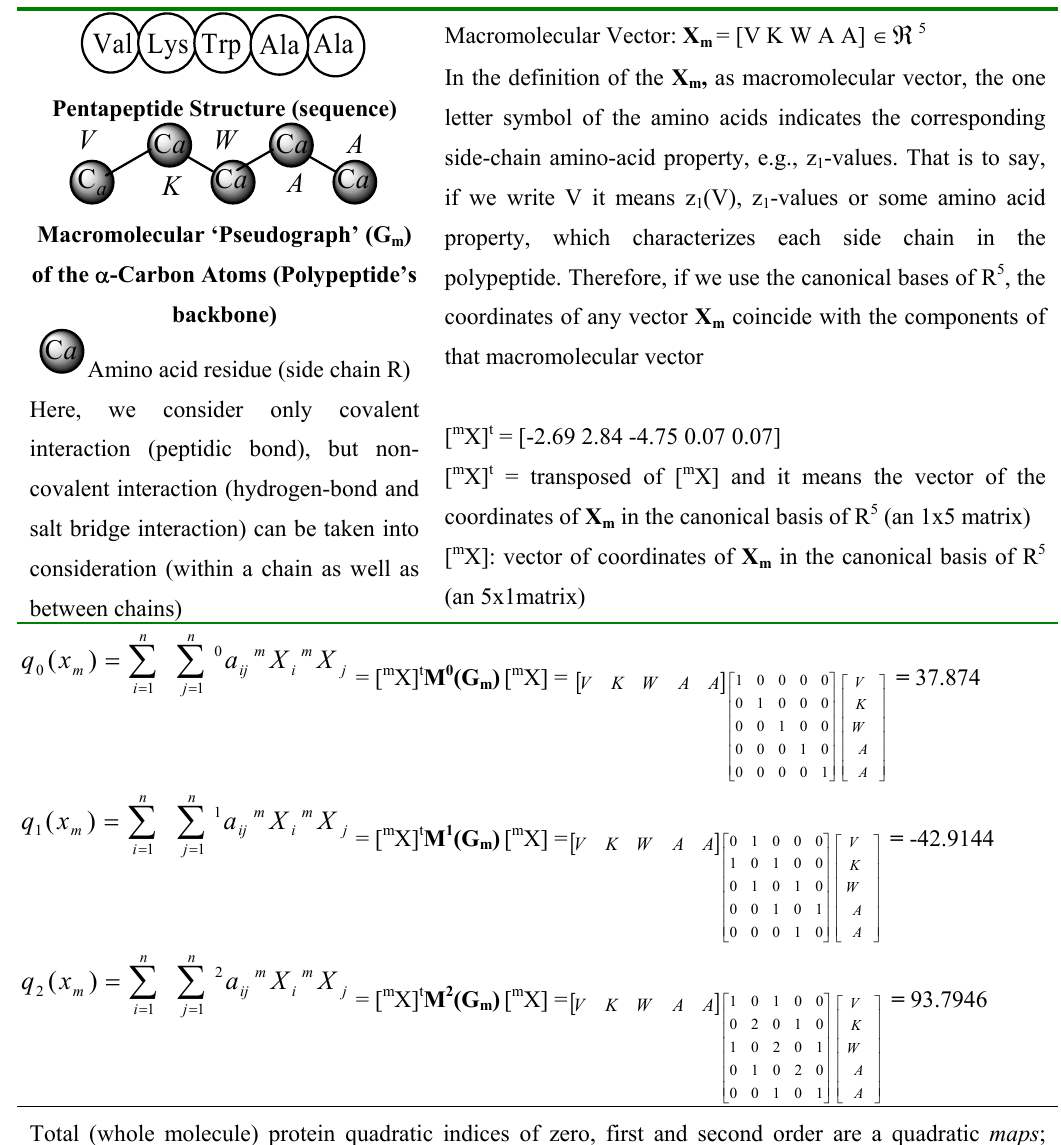
Table 3. Definition and Calculation of Three ( k = 0-2) Total and Local (Side Chain Amino Acid) Protein Quadratic Indices of the “Macromolecular